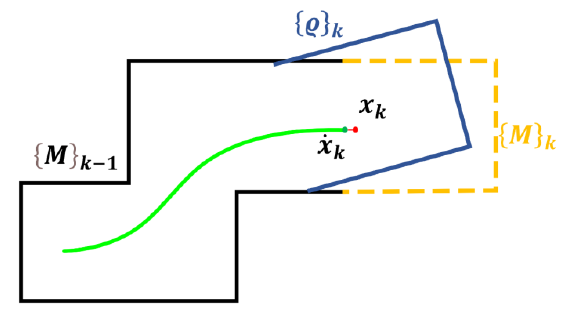
Figure 4. Map construction and optimization.